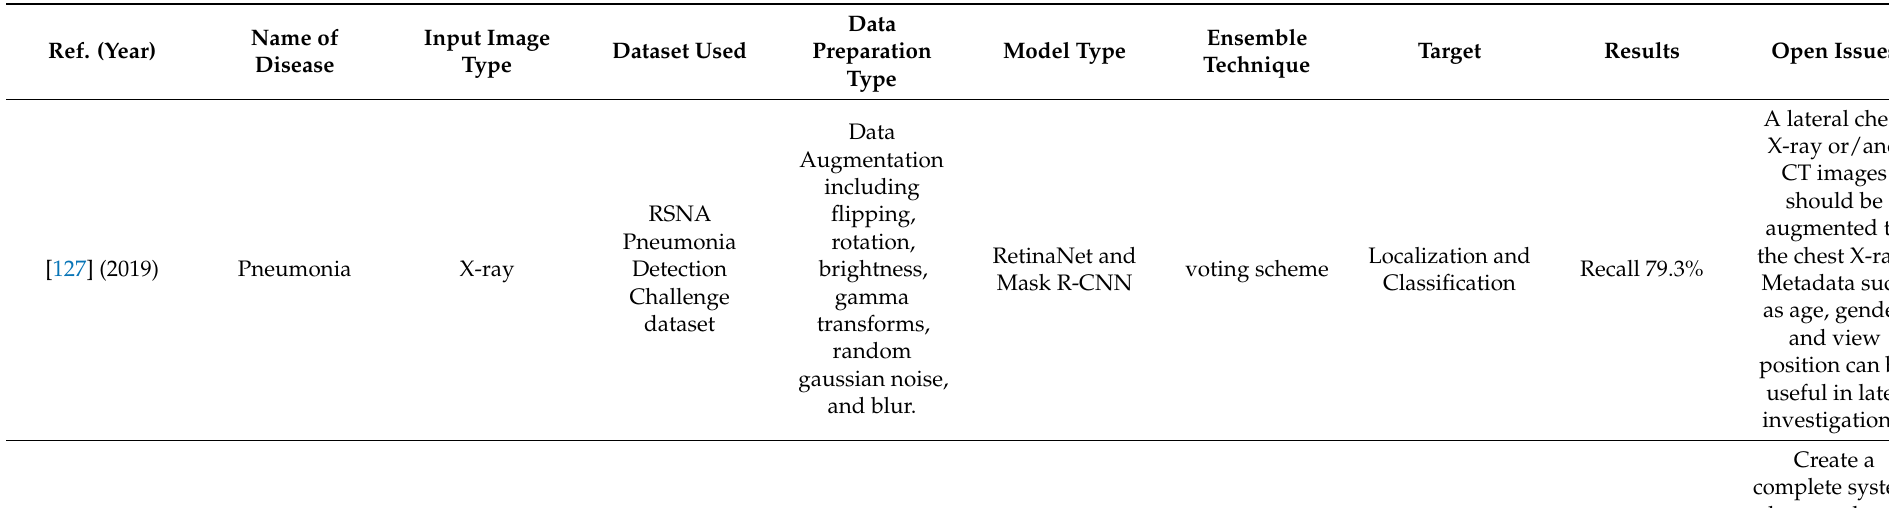
Table 3. Lung diseases detection summary that affect